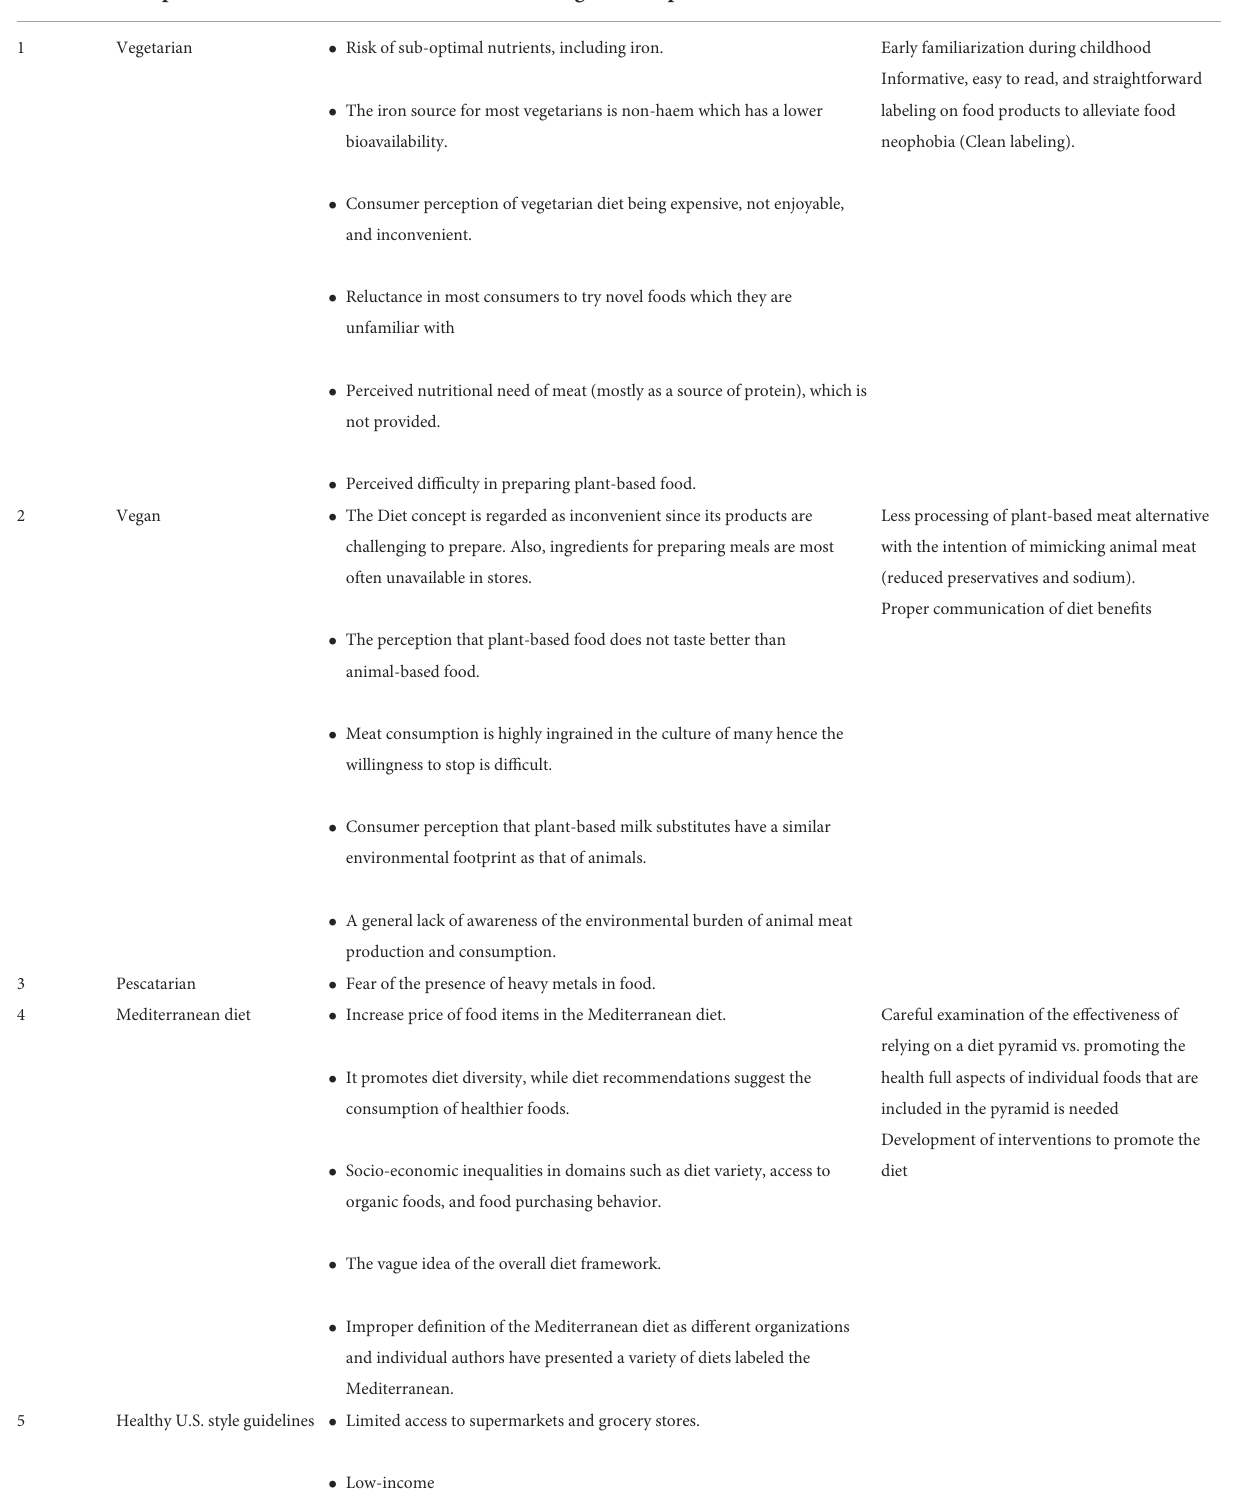
TABLE 5 Bottleneck to implementing sustainable diet concepts. S/N Diet